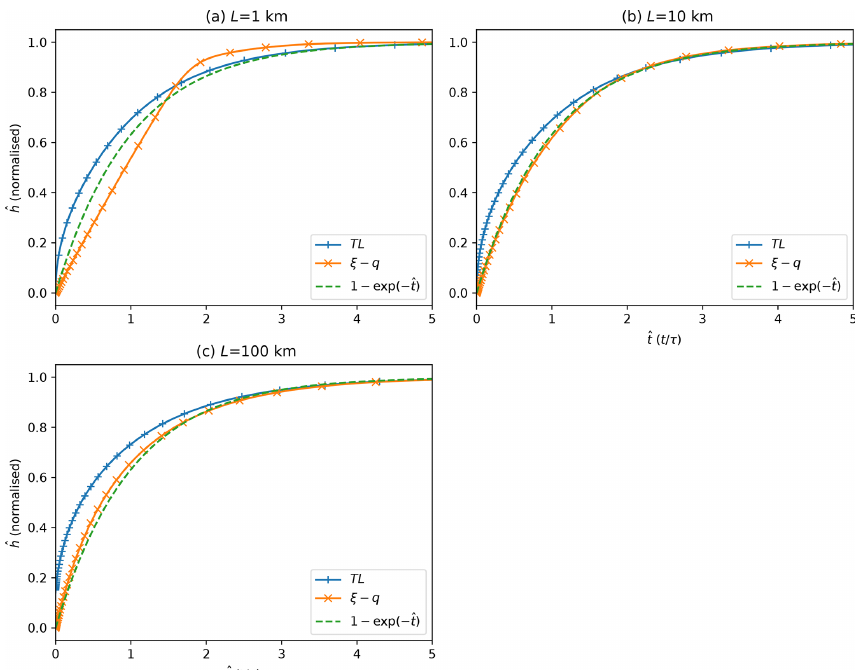
Figure 5. Maximum surface elevation as a function of time. Surface elevation is normalized by its maximum value and time by the e-folding timescale, τ . The three panels correspond to different length of the system compared to L 0 (a) L = L 0 / 10 (constrained systems), (b) L = L 0 and (c) L = 10 L 0 . (open systems) In each panel the curves correspond to the solutions to the ξ – q and TL equations and are compared to the third curve representing an exponential increase of the form 1 − exp( t/τ